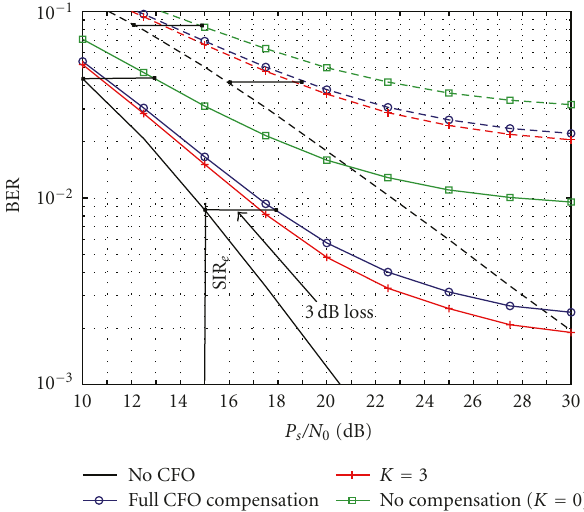
Figure 4: BER performance of 2-user SDMA system distorted by normalized CFO ω = 0 . 1 with ZF receiver. Dashed line: diversity gain μ = 1. Solid line: μ = 2 .